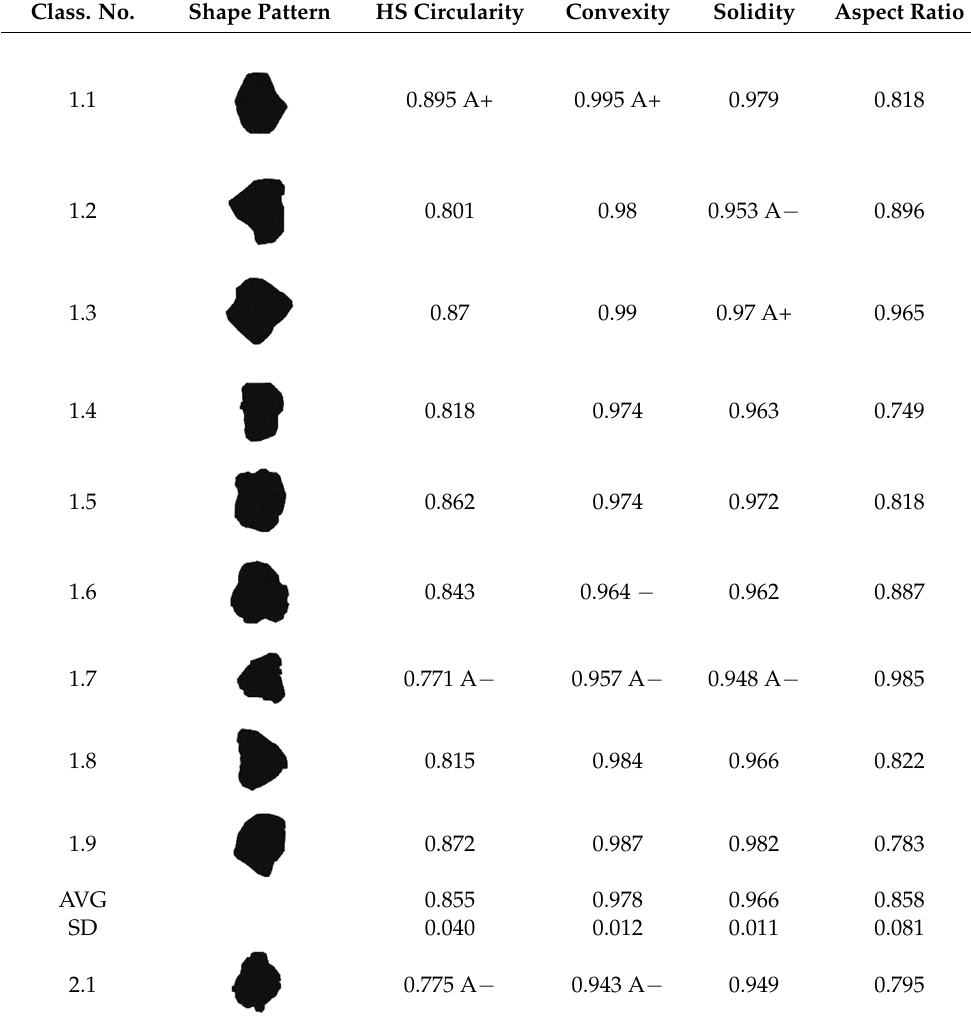
Table 1. Values of morphometric parameters of Krumbein’s grain shape charts. Class. No.